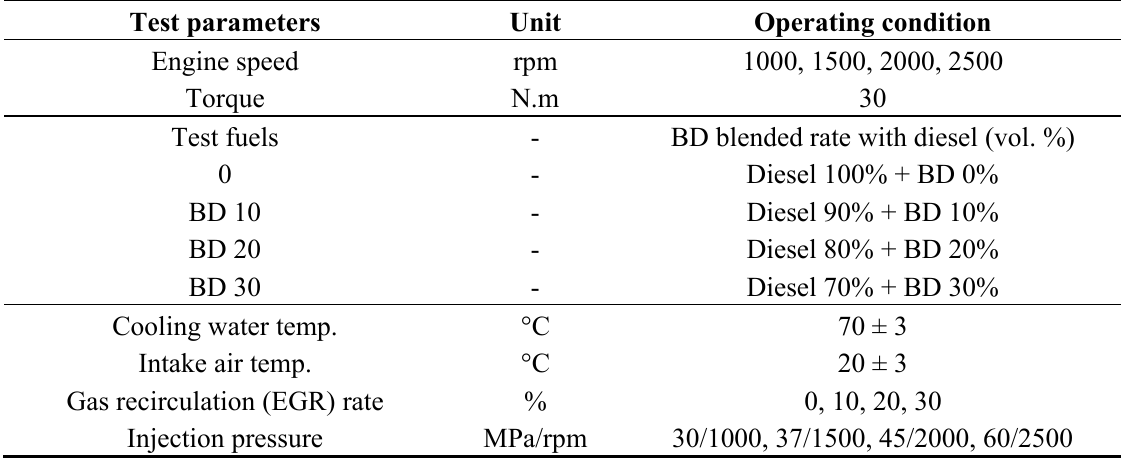
Table 2. Experiment and operating